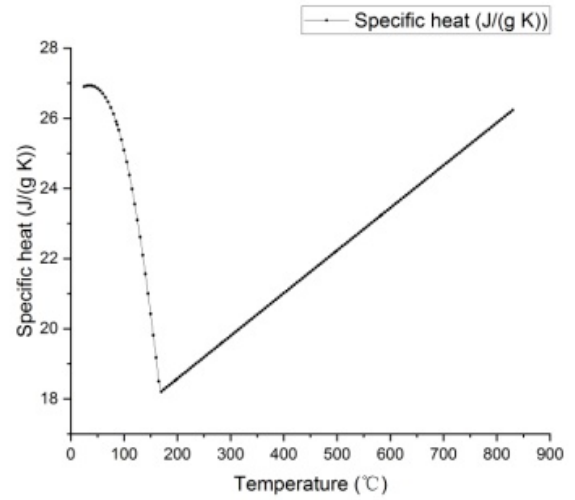
Figure 7. Thermal conductivity of node 1 after one cycle.